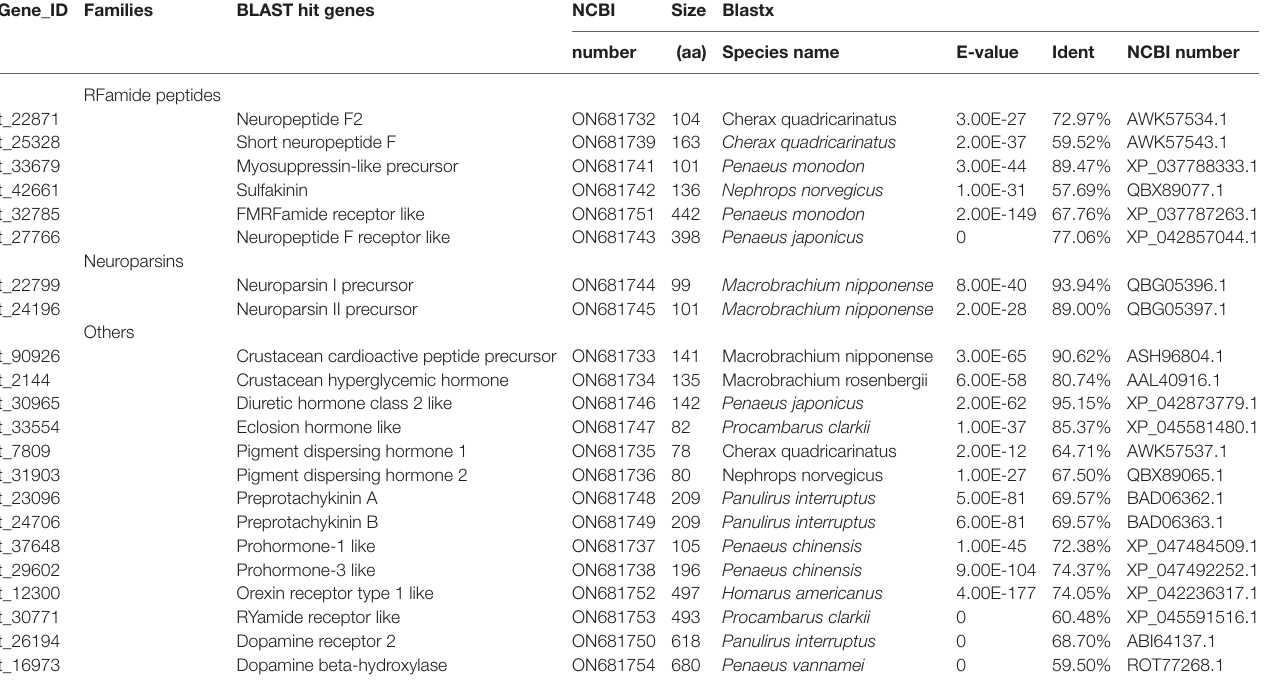
TABLE 2 Putative neuropeptides and related transcripts in the full-length transcriptome of E. carinicauda